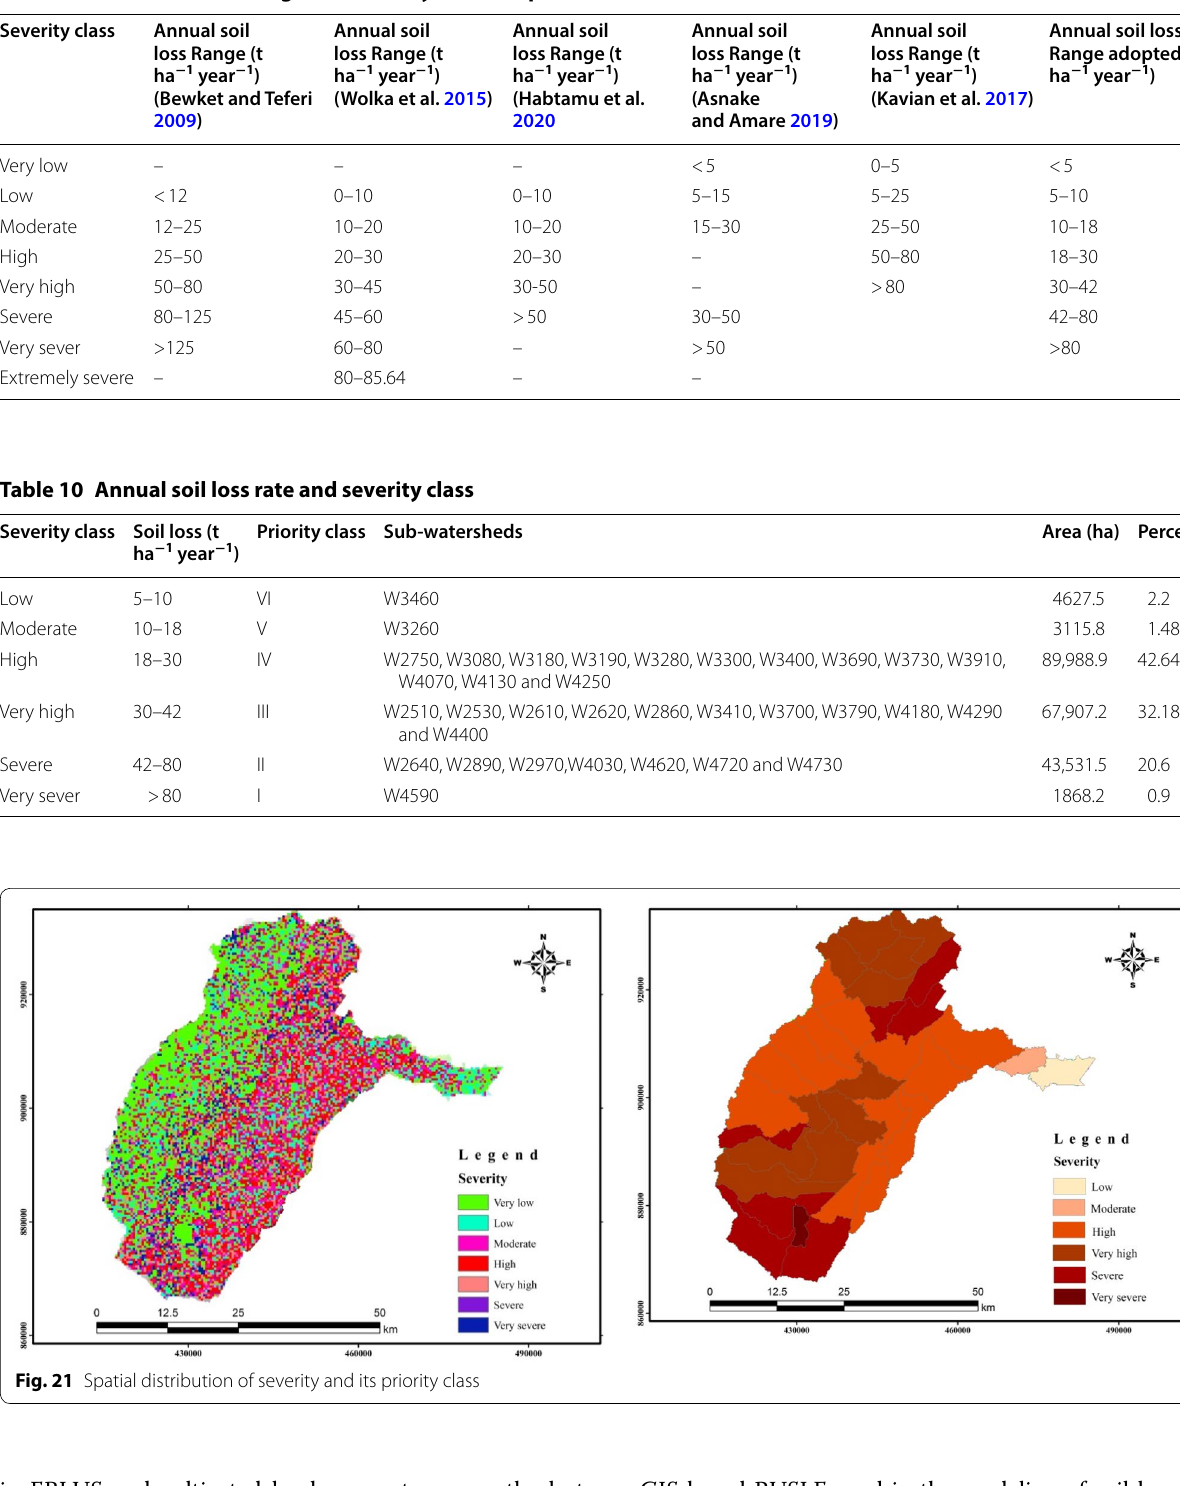
Table 9 Annual soil loss Range and severity class adoption